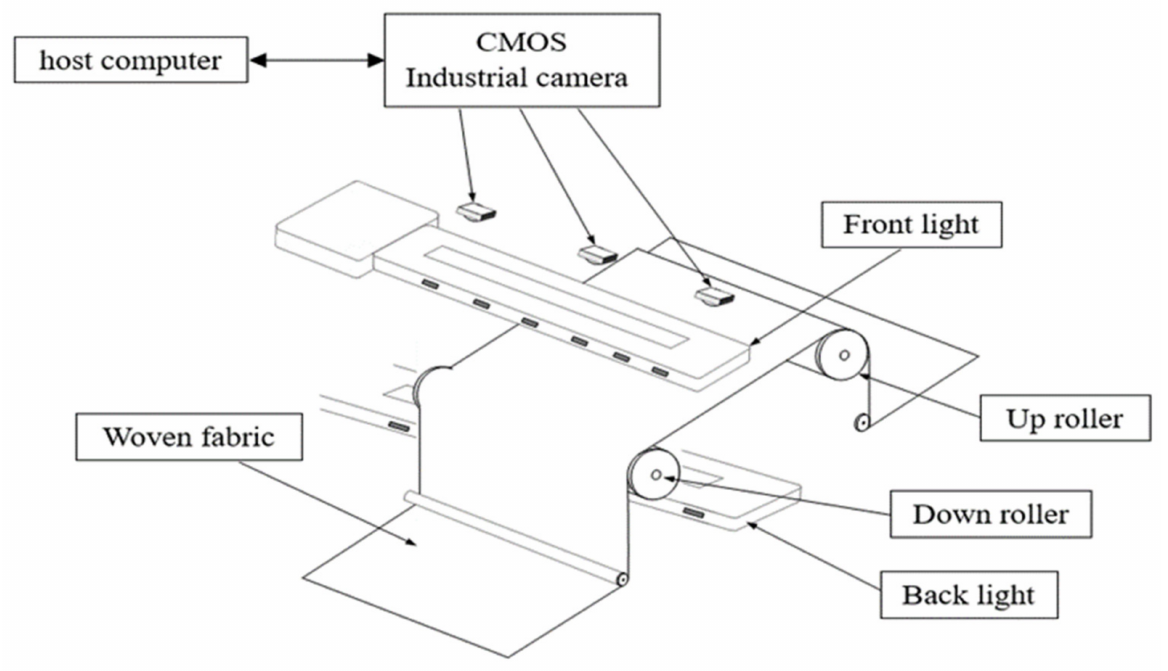
Figure 8. Schematic diagram of the experimental